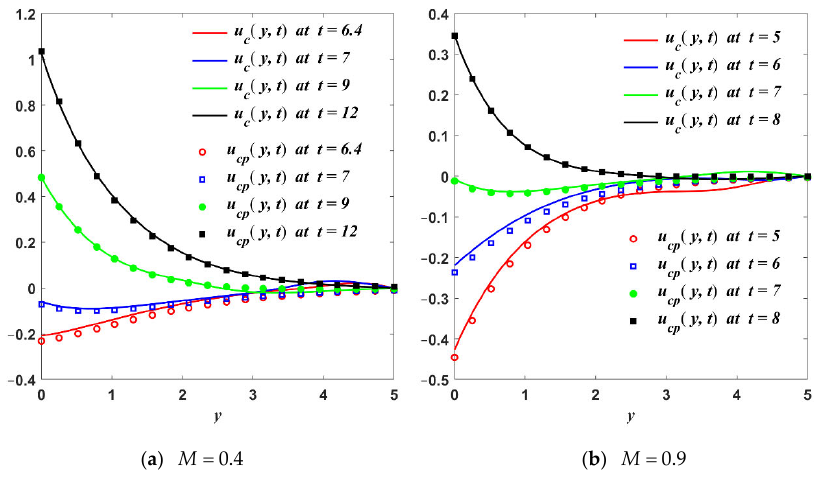
Figure 5. Convergence of starting velocity u c ( y , t ) (numerical solution) to its steady-state component u cp ( y , t ) for α = 0.8, β = 0.7, γ = 0.6, ω = π /12, K = 0.4, and two values of M .